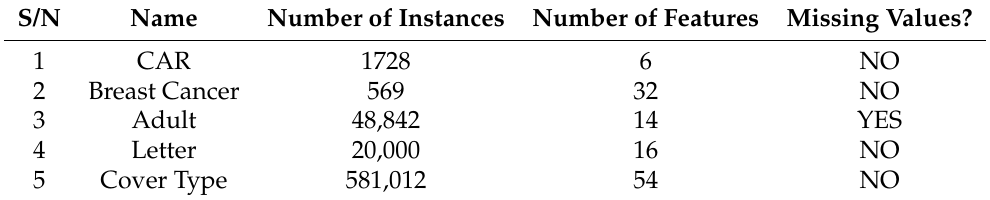
Figure 2. Some of the images present in the MNIST dataset. Table 1. Summary of the UCI